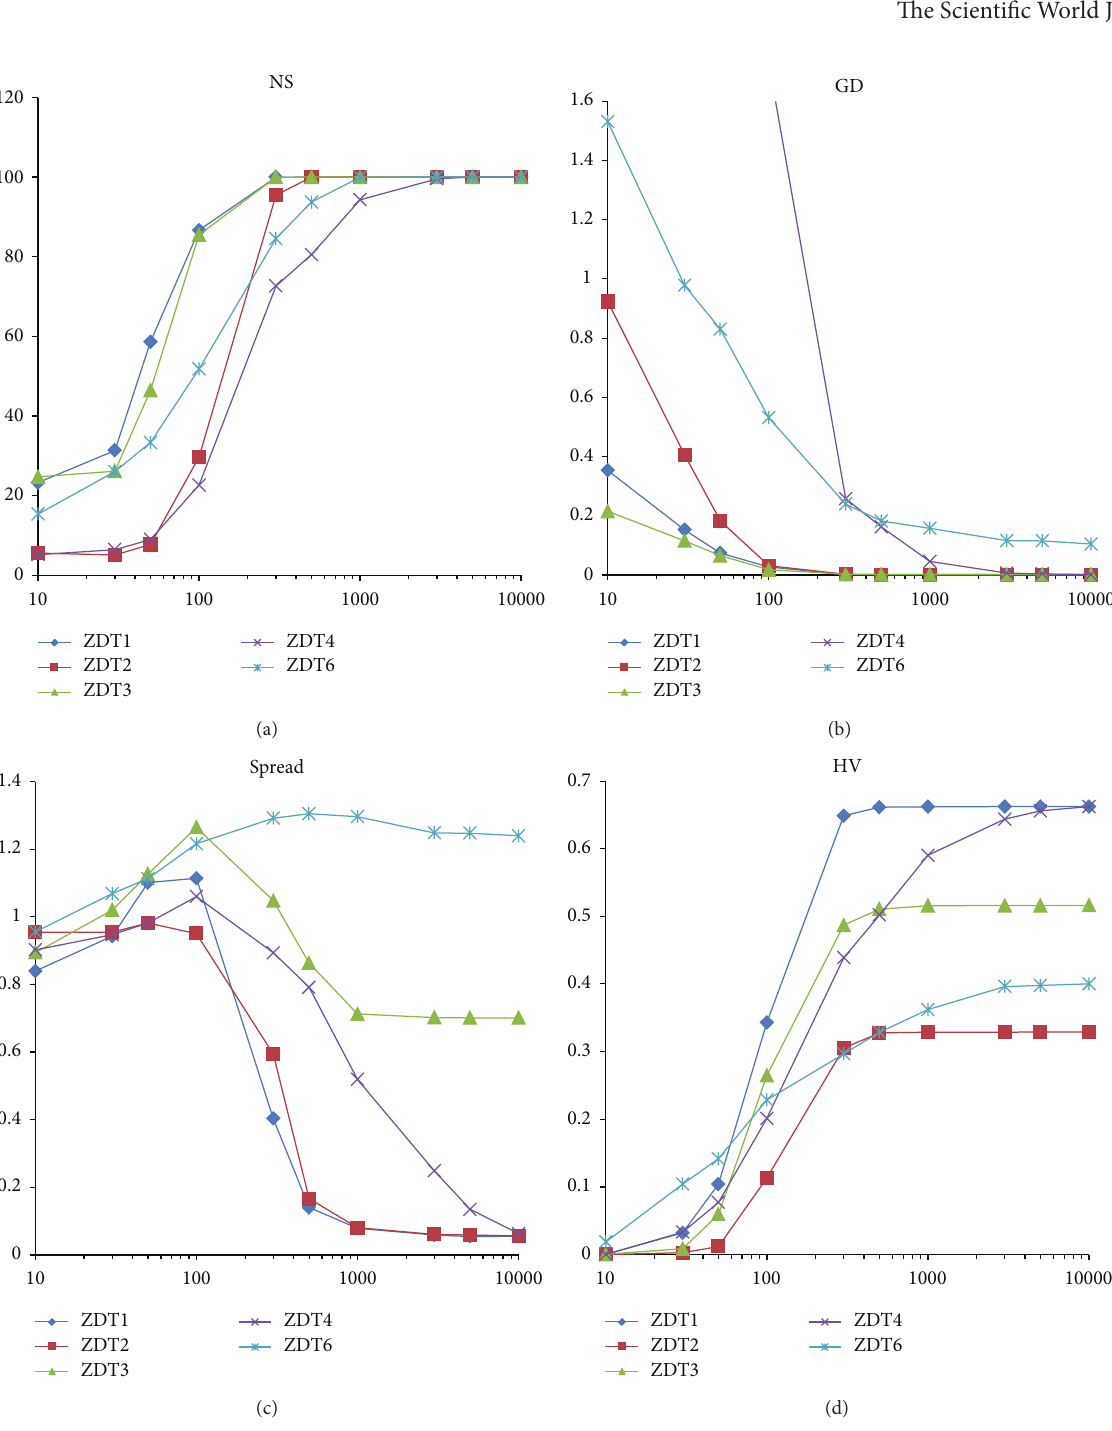
Figure 11: Plots of the performance metrics for various numbers of iterations. (a) Number of solution. (b) Generational distance. (c) Spread. (d)